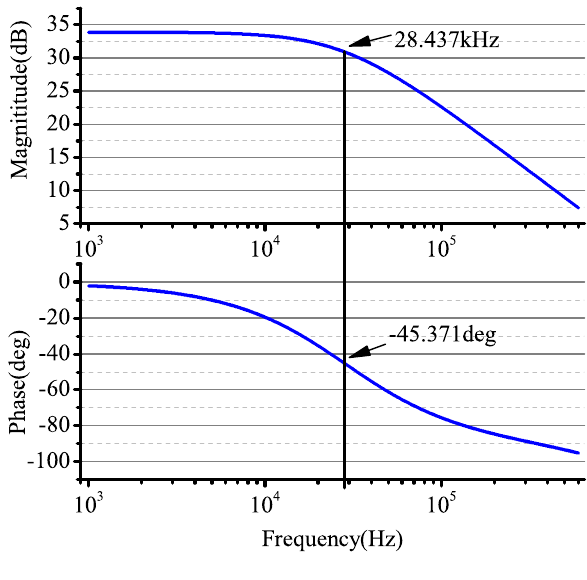
Figure 11. The Bode plot of the small signal extracting system in the driving